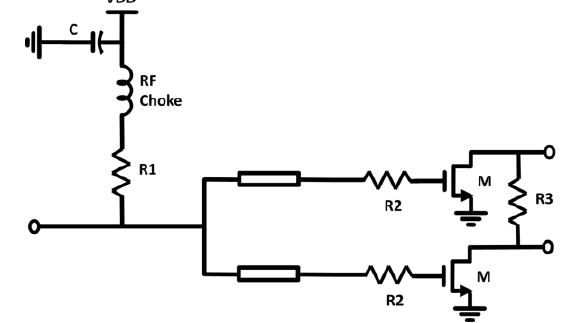
Figure 5: Schematic for stability resistances